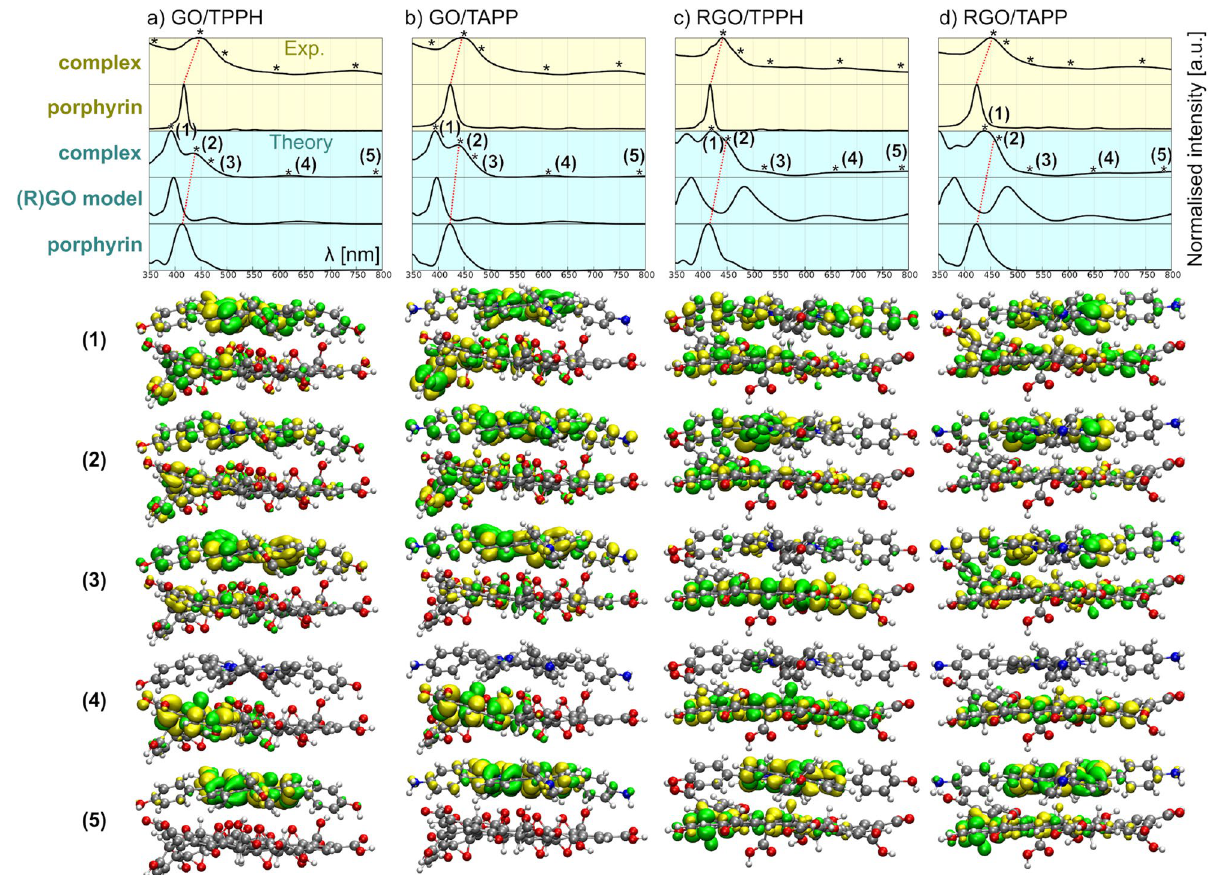
Figure 7. Top: comparison of experimental (yellow background) and computed (cyan background) absorption spectra. For each panel the spectra plotted are from the top: nanohybrid (exp), porphyrin (exp), nanohybrid (theory), graphene species (theory) and porphyrin (theory). Red dotted line guides identification of Soret-band shift in theory and experiment. Bottom: isosurface plots of transition densities for key electronic excitations (1)– (5) for all systems